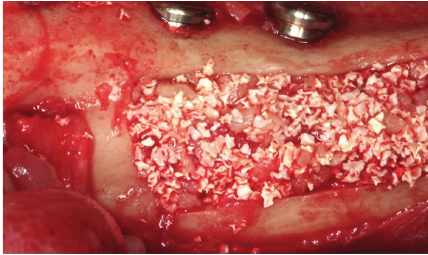
Figure 18: Intermediate fill (autogenous and hydroxyapatite bone).